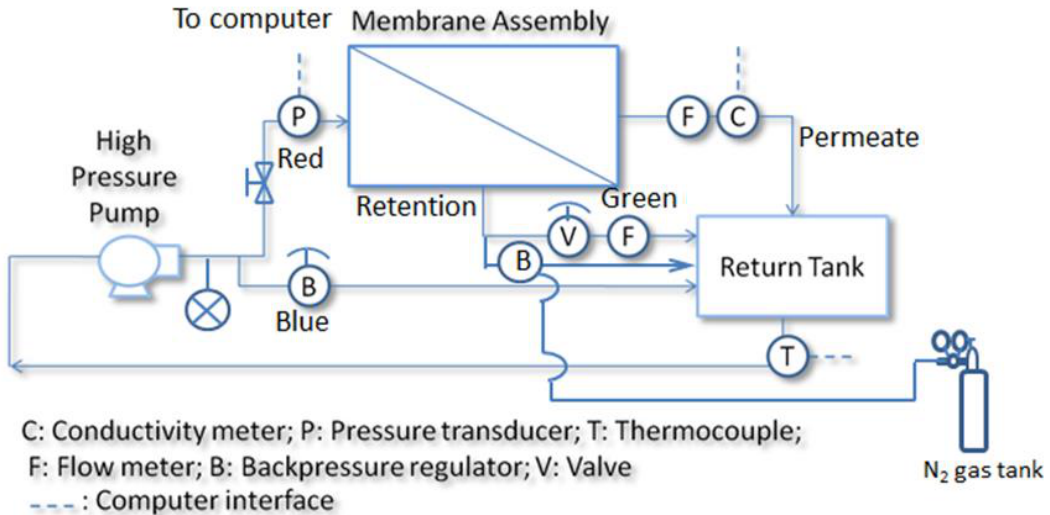
Figure 3. Process flow diagram (PFD) of the custom-built desalination Figure 3 . Process flow diagram (PFD) of the custom-built desalination system.